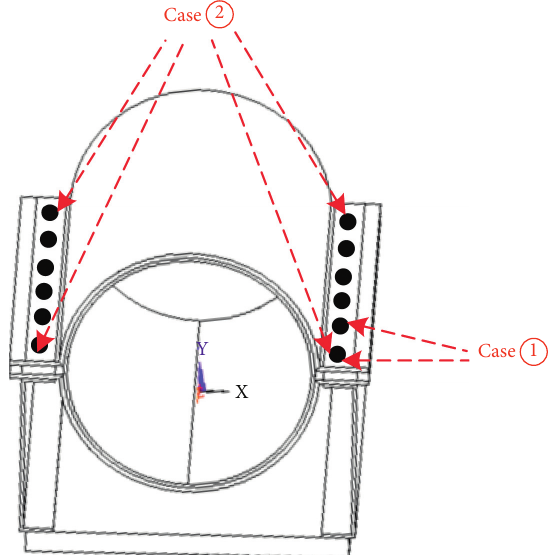
Figure 4: Bolt looseness simulation for the first two